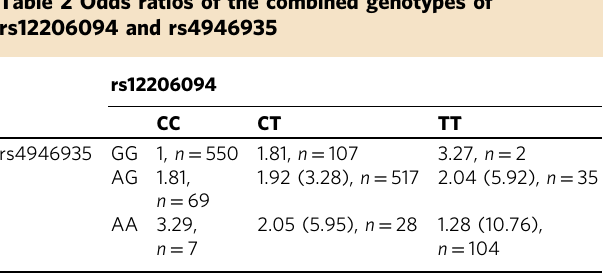
Given are the odds ratios (ORs) for the allelic interaction model (multiplicative OR scale). In brackets are the theoretic combined ORs if no interaction were present (given the same single SNV ORs). The underlying population is the German longevity sample with 594 centenarians and 918 younger controls. n = number of